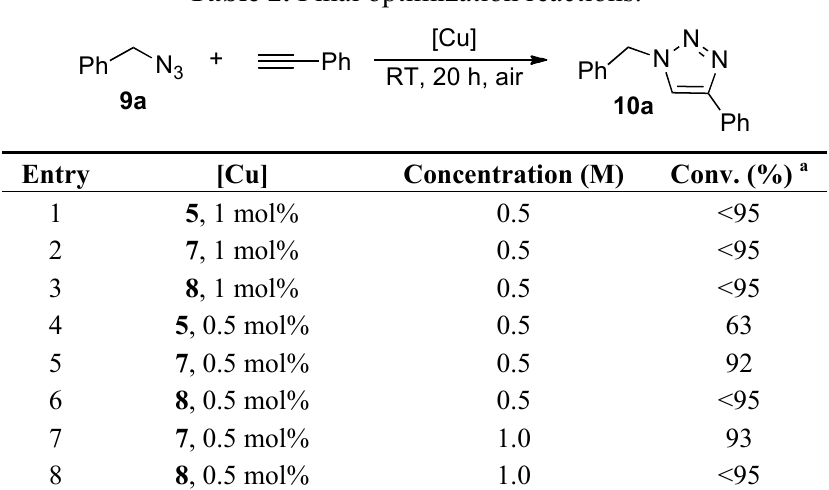
Table 2. Final optimization